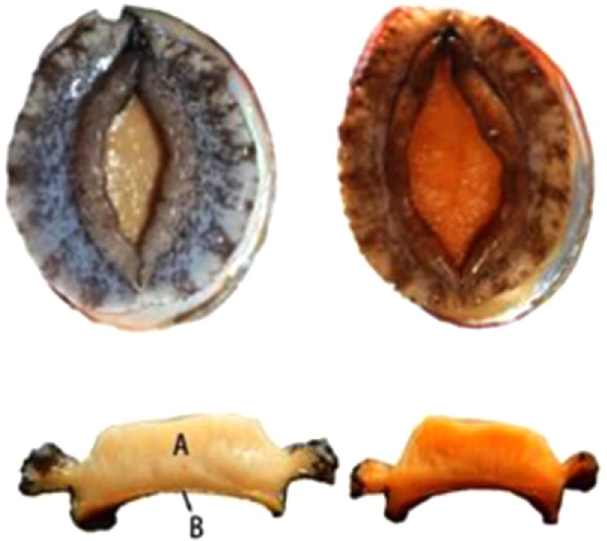
Figure 6. Abalones with common (left) and orange (right) muscles (top). Cross-sectional view of abalone muscles (bottom), with labeling of adductor (A) and foot (B)